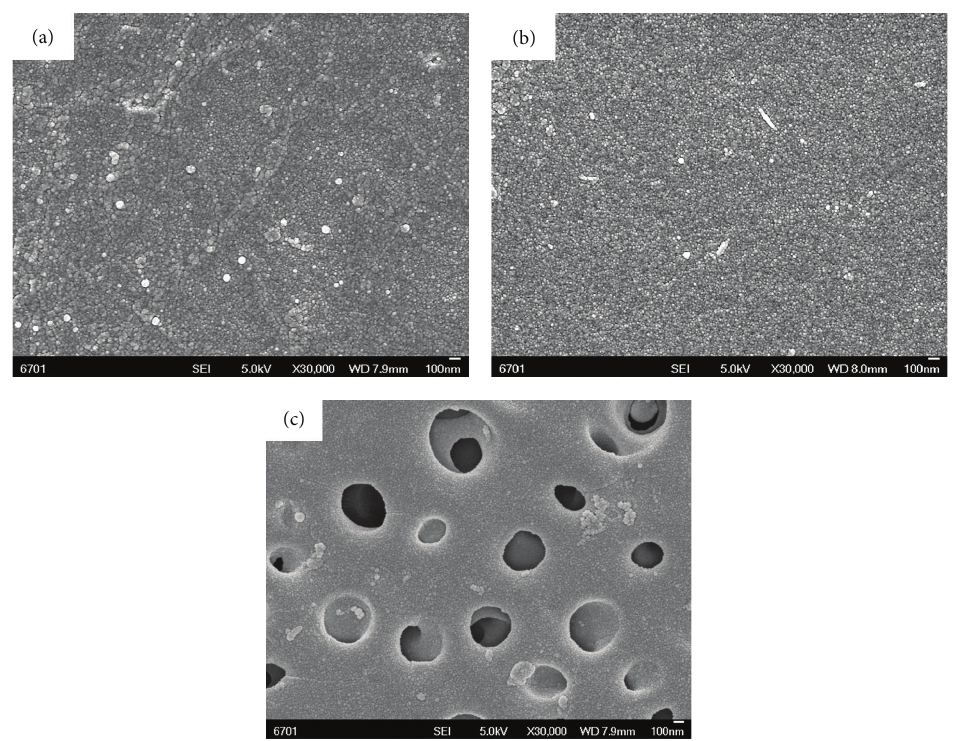
Figure 7: SEM images of M-PAANa prepared at different modifier concentrations: (a) 0.8, (b) 2, and (c) 5